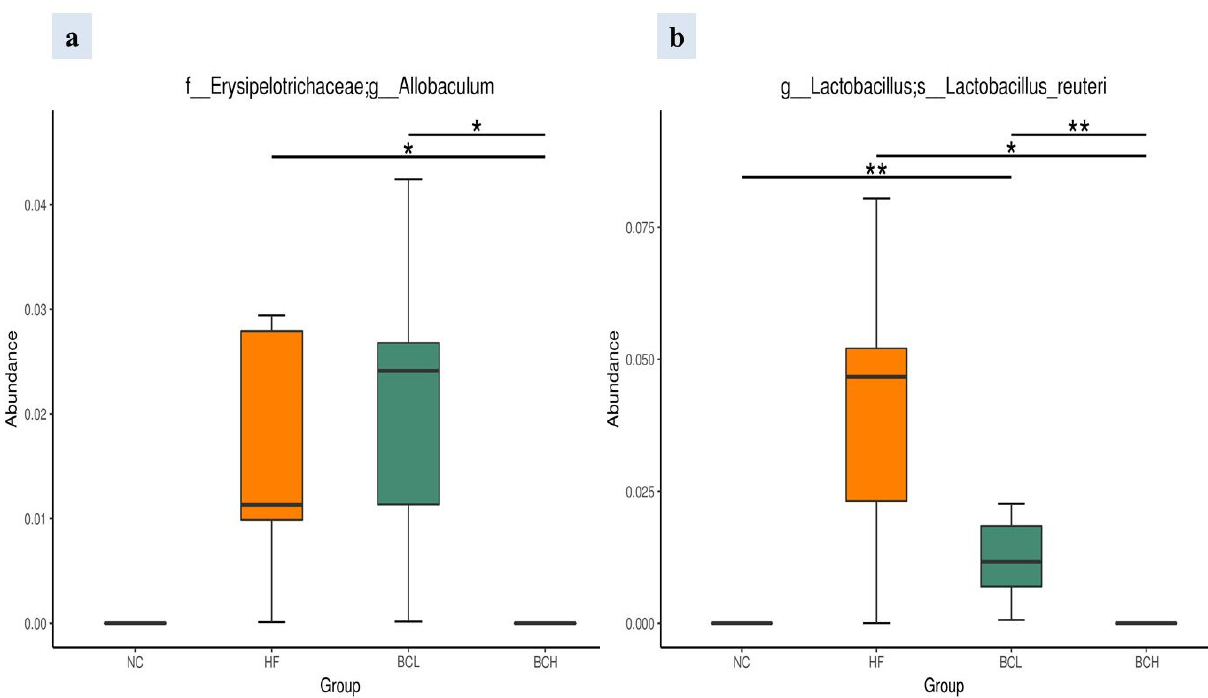
Figure 8. Identifications of the abundance of ( a ) Allobaculum genus and ( b ) Lactobacillus reuteri in fecal samples of rats fed chow diet (NC group), high-fat diet (HF group), high-fat diet + low dose of B. coagulan BACO-17 (7 log CFU/day) (BCL group), and high-fat diet + high dose of B. coagulan BACO-17 (9 log CFU/day) (BCH group) by metagenomeSeq analysis. *, p < 0.05 and **, p < 0.01 (n = 5 per group).